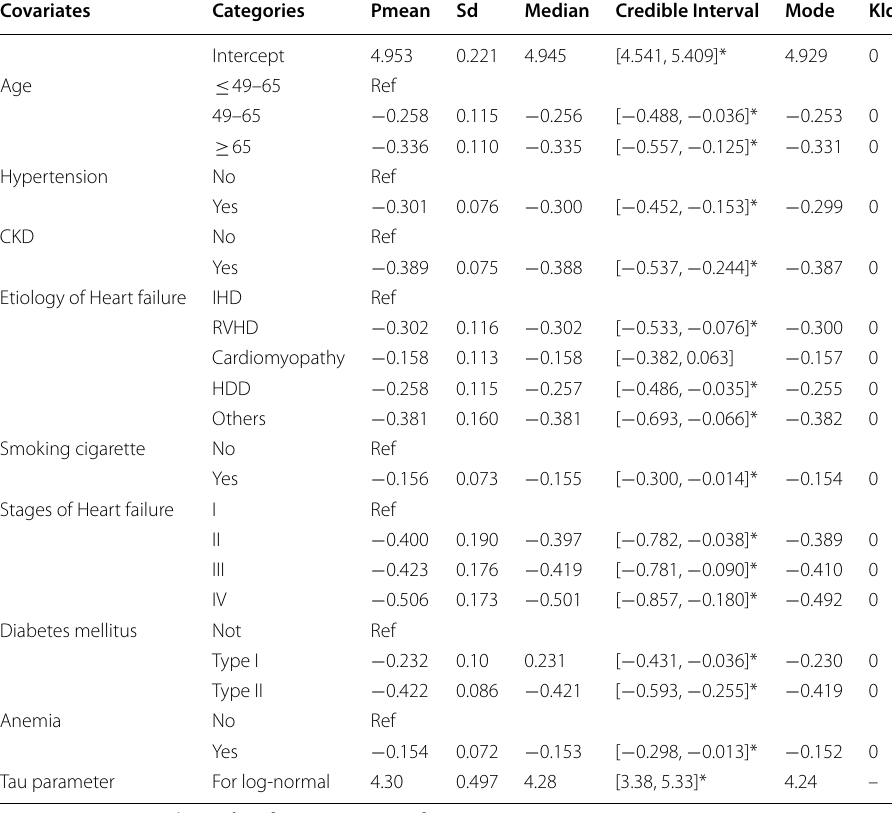
Source: JUMC, Jimma, Ethiopia; from first January 2016 to first January 2019 * Is indicated statistically significant. Pmean, Posterior Mean; CKD, Chronic kidney disease; IHD, Ischemic heart disease; RVHD, Rheumatic valvular heart disease; HHD, Hypertensive heart disease, Sd, Standard deviation, KLD, Kullback–Leibler Divergence